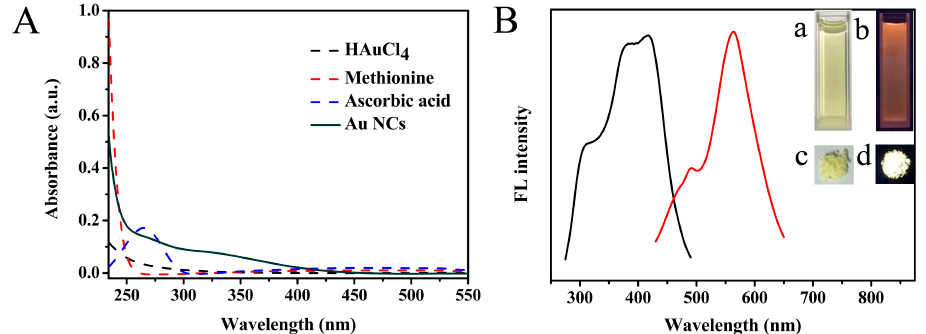
Figure 2. UV–vis absorption spectra ( A ) and fluorescence excitation (black) and emission (red) spectra ( B ) of the as-synthesized Au NCs. The insets of B show photographs of the Au NC aqueous solution in room light (a) and UV light (b), and powder in room light (c) and UV light